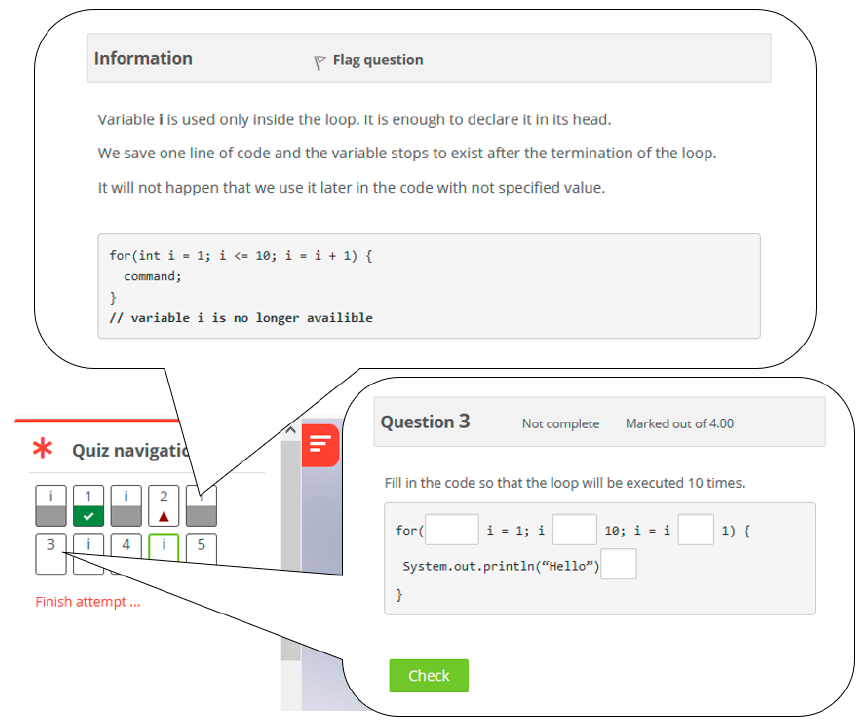
Figure 3. View to the microlearning structure and content represented by the quiz. The suitable rotation of content activities and interactive activities is ensured by the sequence of different types of questions in the quiz.